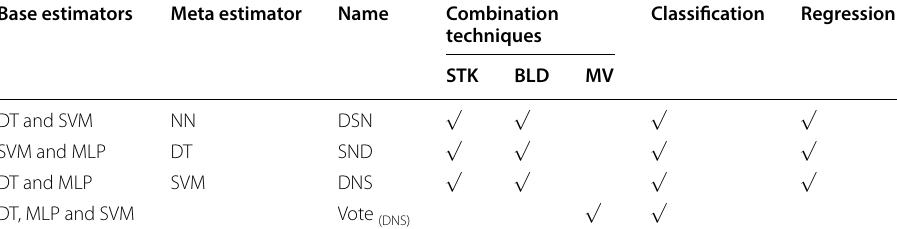
Table 5 Heterogeneous ensembles classifiers and